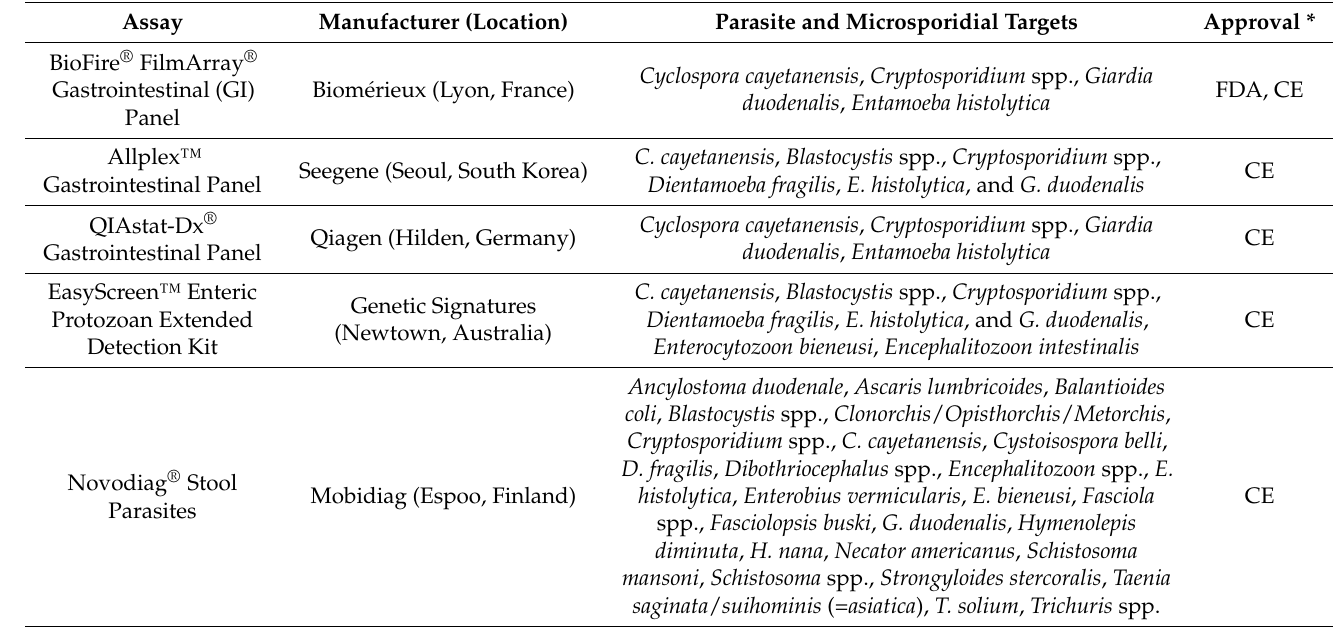
Table 2. Commercially available nucleic acid amplification tests (NAATs) for the detection of Cyclospora cayetanensis . Assay Manufacturer